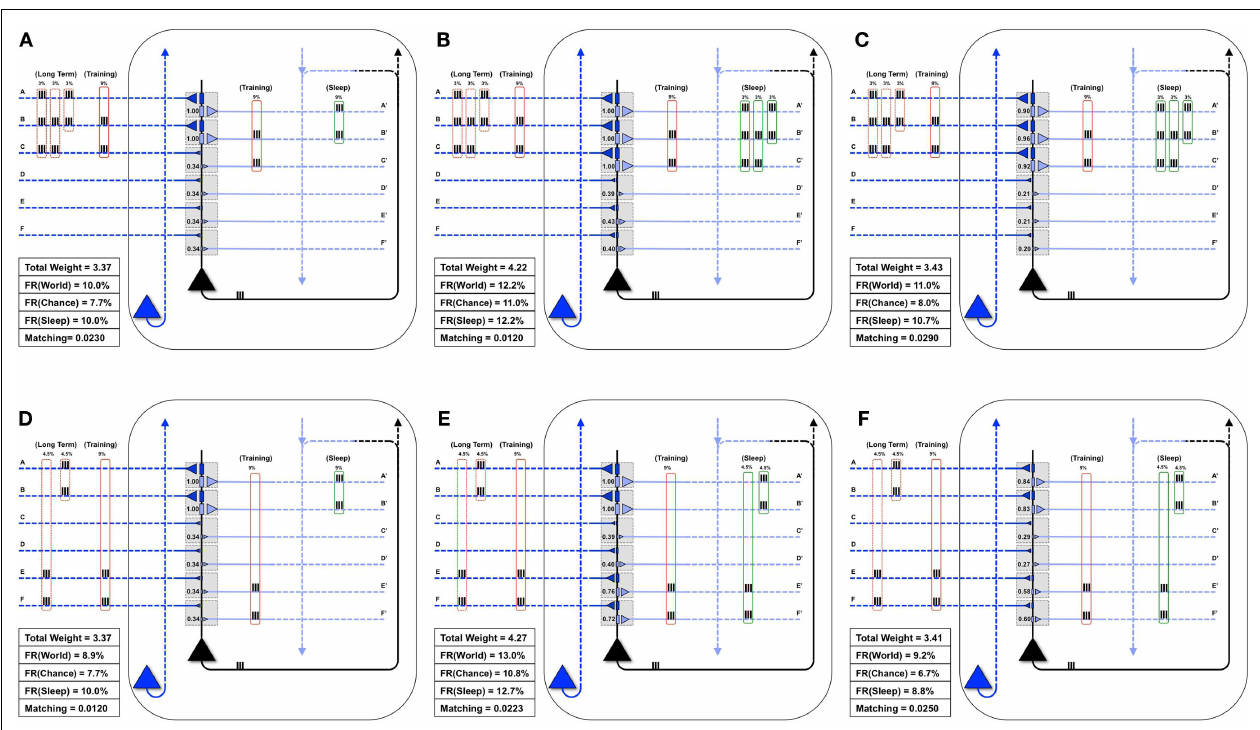
improves. (D) Another neuron also starts with strong synapses A/A (cid:48) and B/B (cid:48) . The Long-Term statistics of the World show disjoint correlations AB (4.5%) and EF (4.5%) (shown in the dashed red boxes on the left). During Training , the neuron is exposed to correlations EF (9%) (shown in the solid red boxes). (E) After training in wake, synapses E/E (cid:48) and F/F (cid:48) have been potentiated. (F) During activity-dependent synaptic down-selection in sleep (with the inputs shown in the green boxes on the right), inputs on A and B are activated independently of inputs on E and F. As a result, both pairs of synapses become slightly more depressed than for the neuron showing overlapping reactivation of inputs from (C) . As a result, Matching is worse than for the neuron with overlapping inputs/memories ( Figure 6C